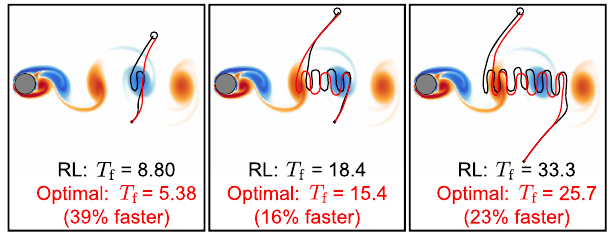
Fig. 6 Comparison between time-optimal and RL trajectories. Time- optimal trajectories are shown in red and RL trajectories are shown in black. The RL swimmer used the state s = { Δ x , Δ y , u , v }. Time to reach the target T f is made non-dimensional using the timescale